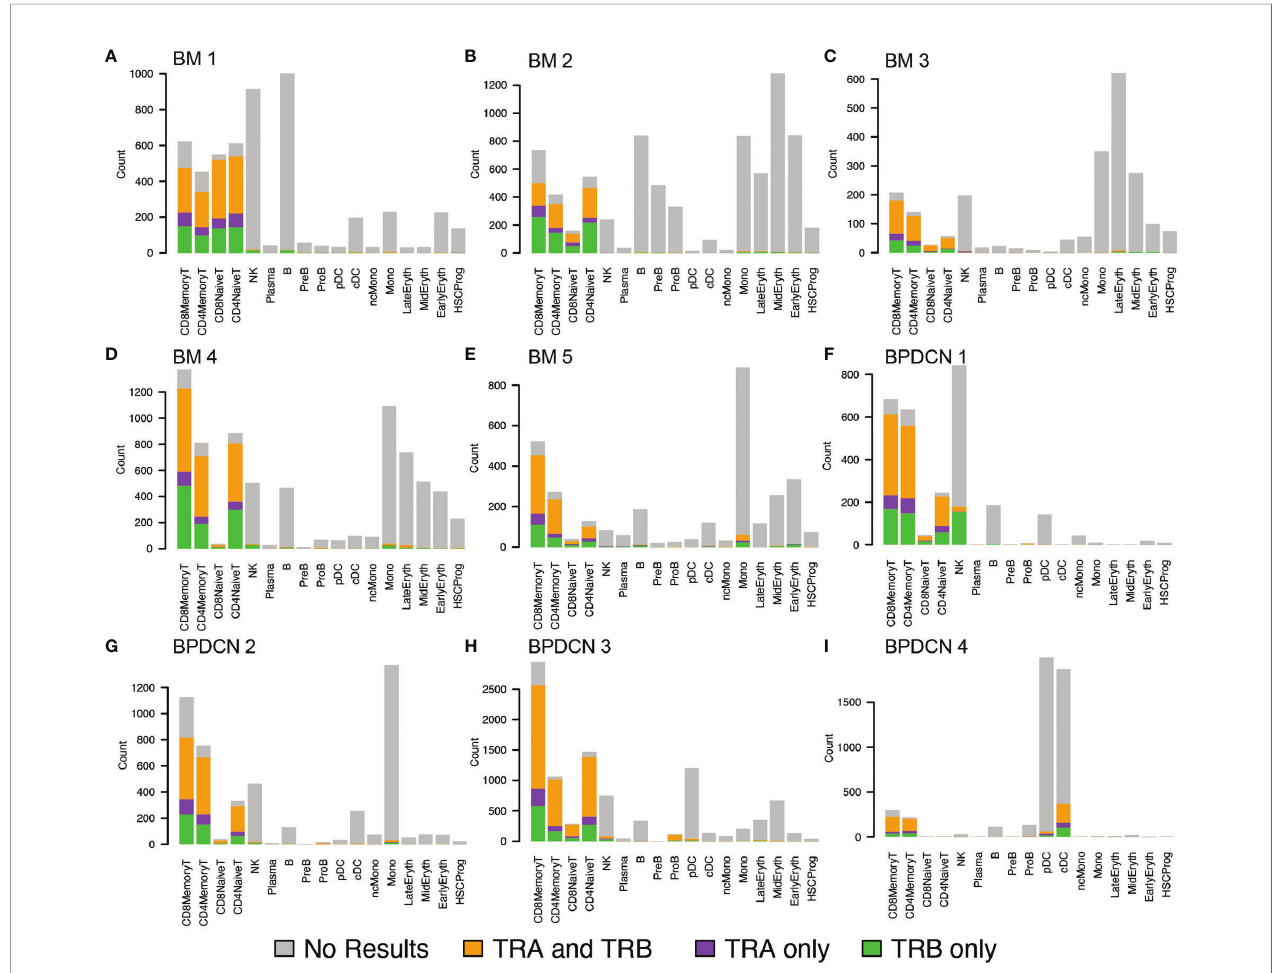
FIGURE 5 | TRA and TRB detection in healthy controls and BPDCN patients by cell type. (A – E) Bar plots for TREK-seq results in BM 1-5 (healthy controls), separated by cell type. For each cell type, represented by a stacked bar, the colors indicate the proportion of TRA, TRB, and both genes mapped to that cell type. (F – I) Bar plots for TREK-seq results in BPDCN 1-4 patient